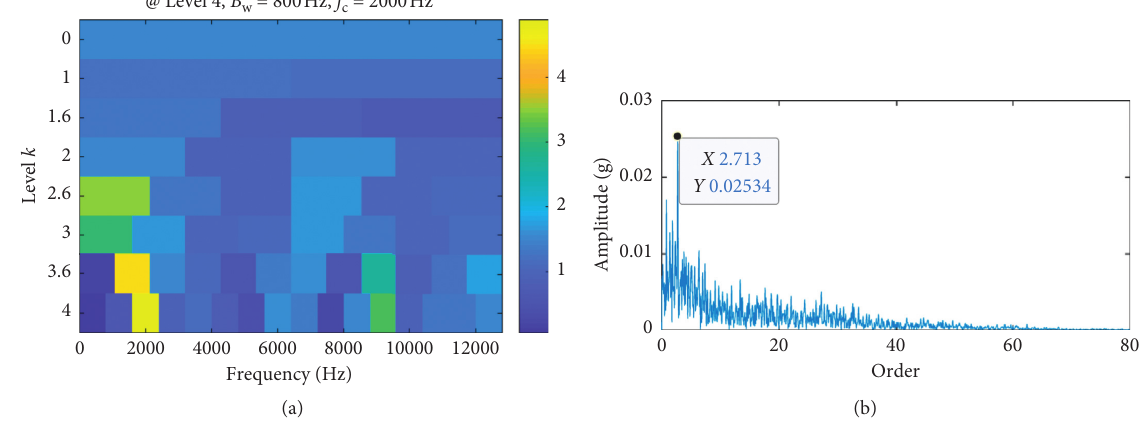
Figure 28: The analysis results for fault data of outer race by using NEA based on SK: (a) kurtogram; (b) envelope order spectrum.